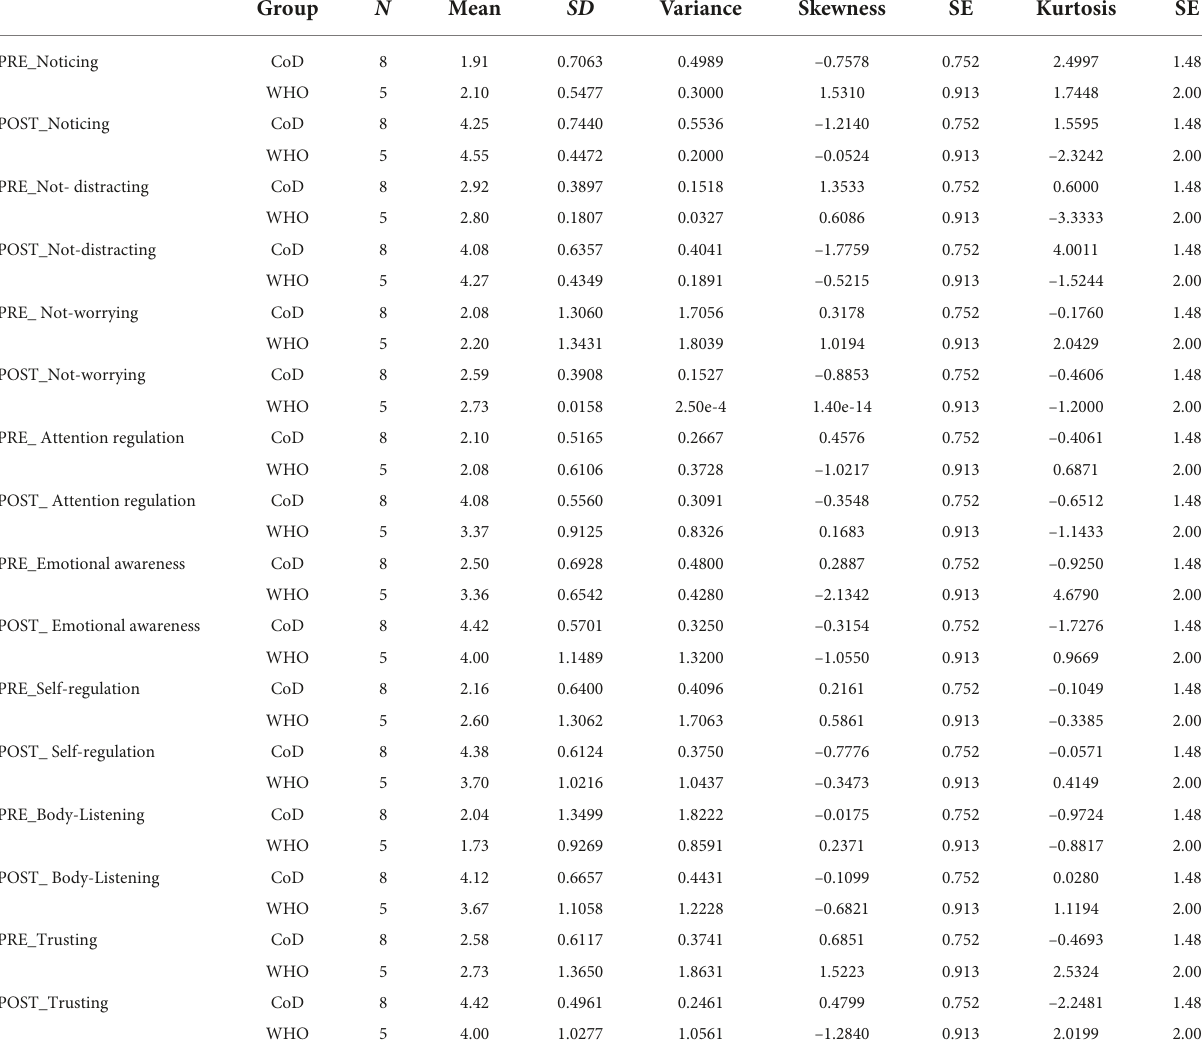
TABLE 3 MAIA questionnaire items